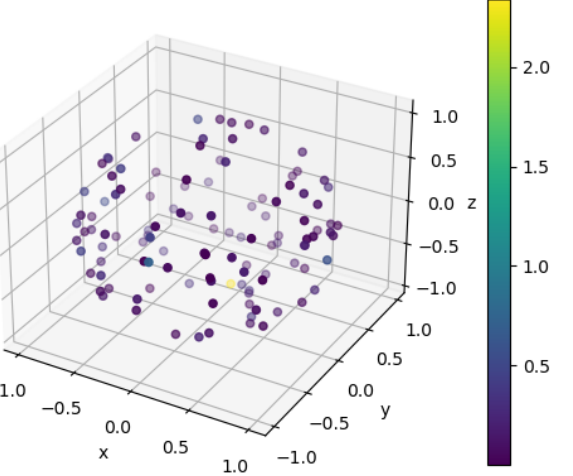
Figure 5. Synthetically generated rotations and their relationship with differences in measured turning angles. Colours represent the absolute difference in turning angles, presented in